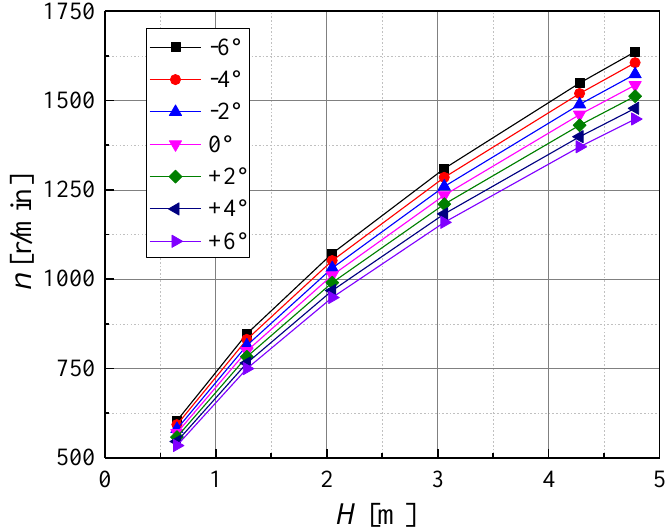
Figure 3. The runaway speed of the axial flow pump under different water heads.